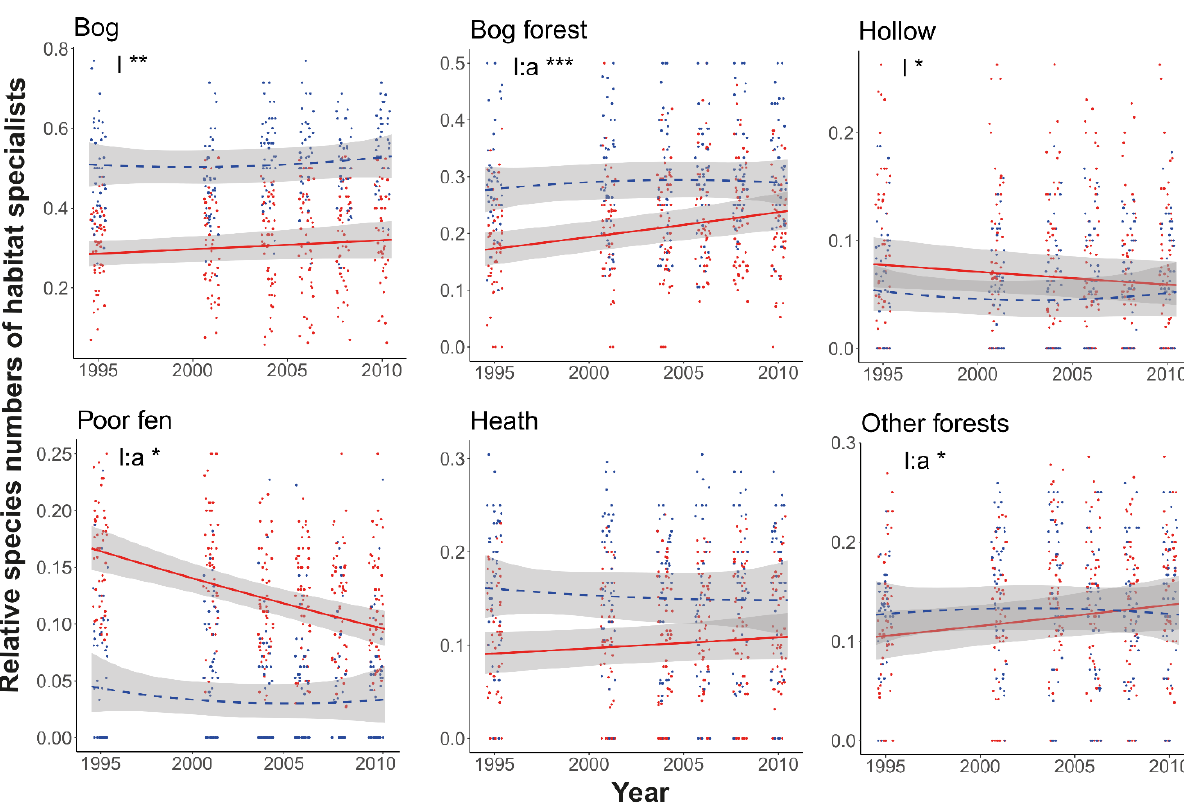
Figure 6. Trends of relative species numbers of habitat specialists for GC-areas (grazing cessation, red) and GCR-areas (grazing cessation plus rewetting, blue). Regression lines and confidence intervals from individual models are displayed. Solid lines show significant trend components. Dashed lines show the model fit of both trend components, if neither of them is significant. Labels denote significant trend differences or significant overall trends derived from the common model. Dots indicate observed values on single plots. Outliers are not shown. l = linear time component; q = quadratic time component; a = area type; a colon indicates an interaction. Significance levels: *: p ≤ 0.05; **: p ≤ 0.01; ***: p ≤